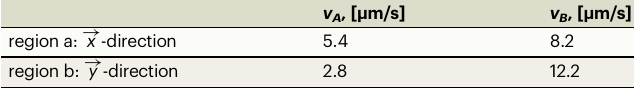
Table 1 | Step front velocities of the two interlaced layers A and B, measured at σ = 0.002 on the crystal shown in Fig. 3 v A , [ μ m/s] v B , [ μ m/s] ! region a: x